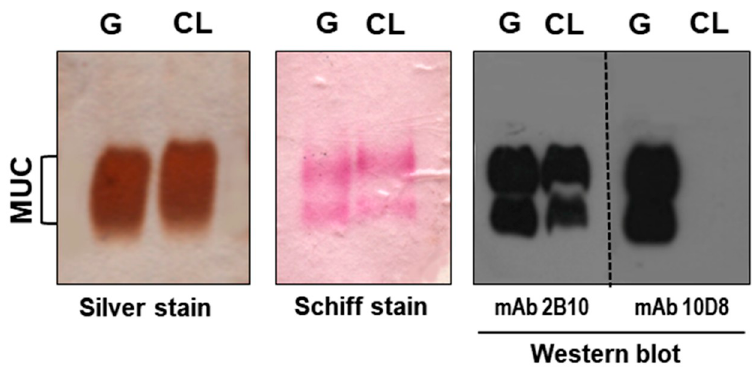
Fig 1. Profile of purified gp35/50 mucins from T . cruzi strains G and CL. Purified mucins were analyzed by silver staining or Schiff staining of SDS-PAGE gel, or by western blot using the indicated gp35/50 mucin-specific